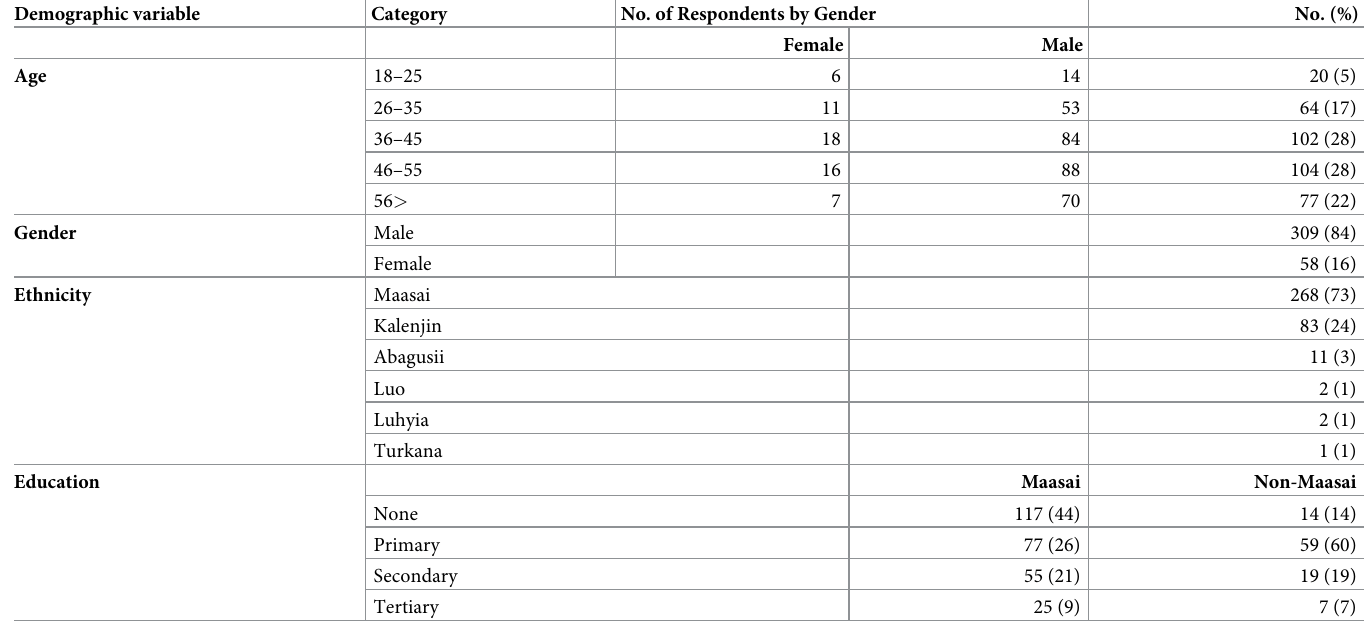
Table 3. Generality of